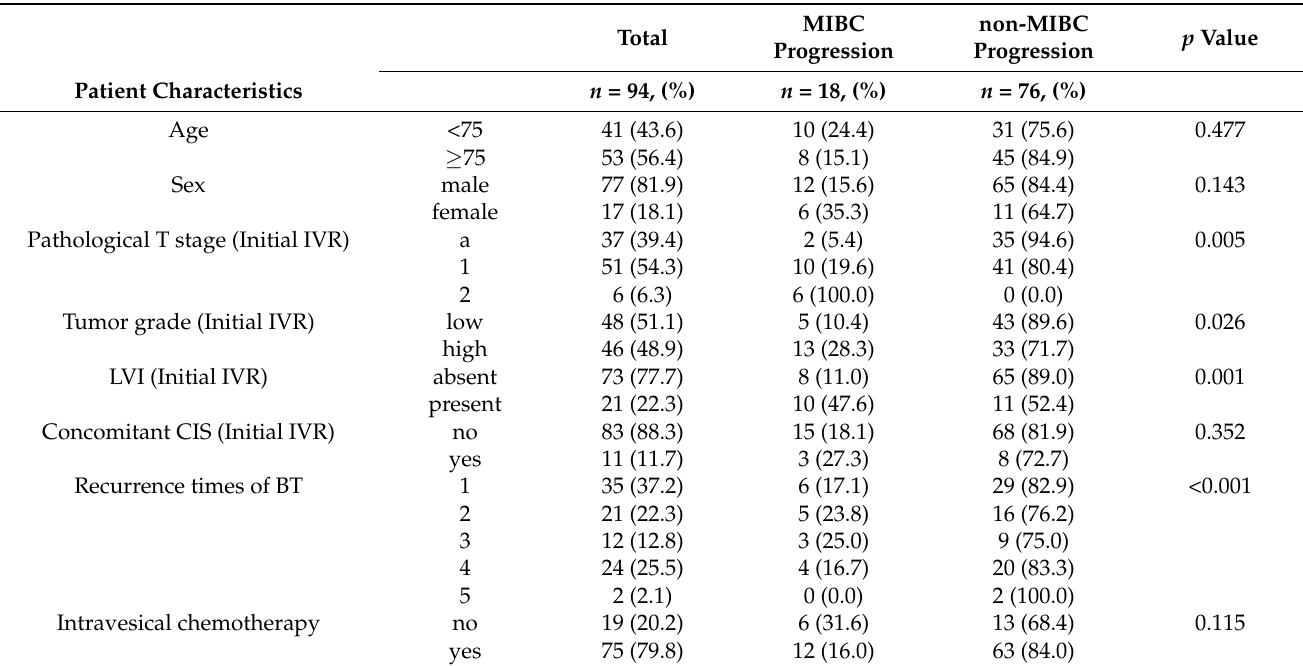
Table 3. Clinicopathological characteristics of UTUC patients who developed IVR. Abbreviations: UTUC; upper tract urothelial carcinoma, IVR; intravesical recurrence, MIBC; muscle invasive blad- der cancer, UC; urothelial carcinoma, LVI; lymphovascular invasion, CIS; carcinoma in situ,